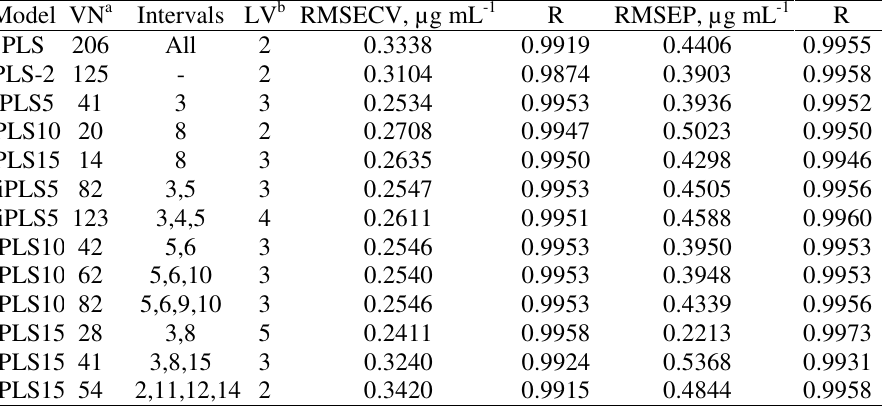
Table 2. Statistical results to AML better calibration